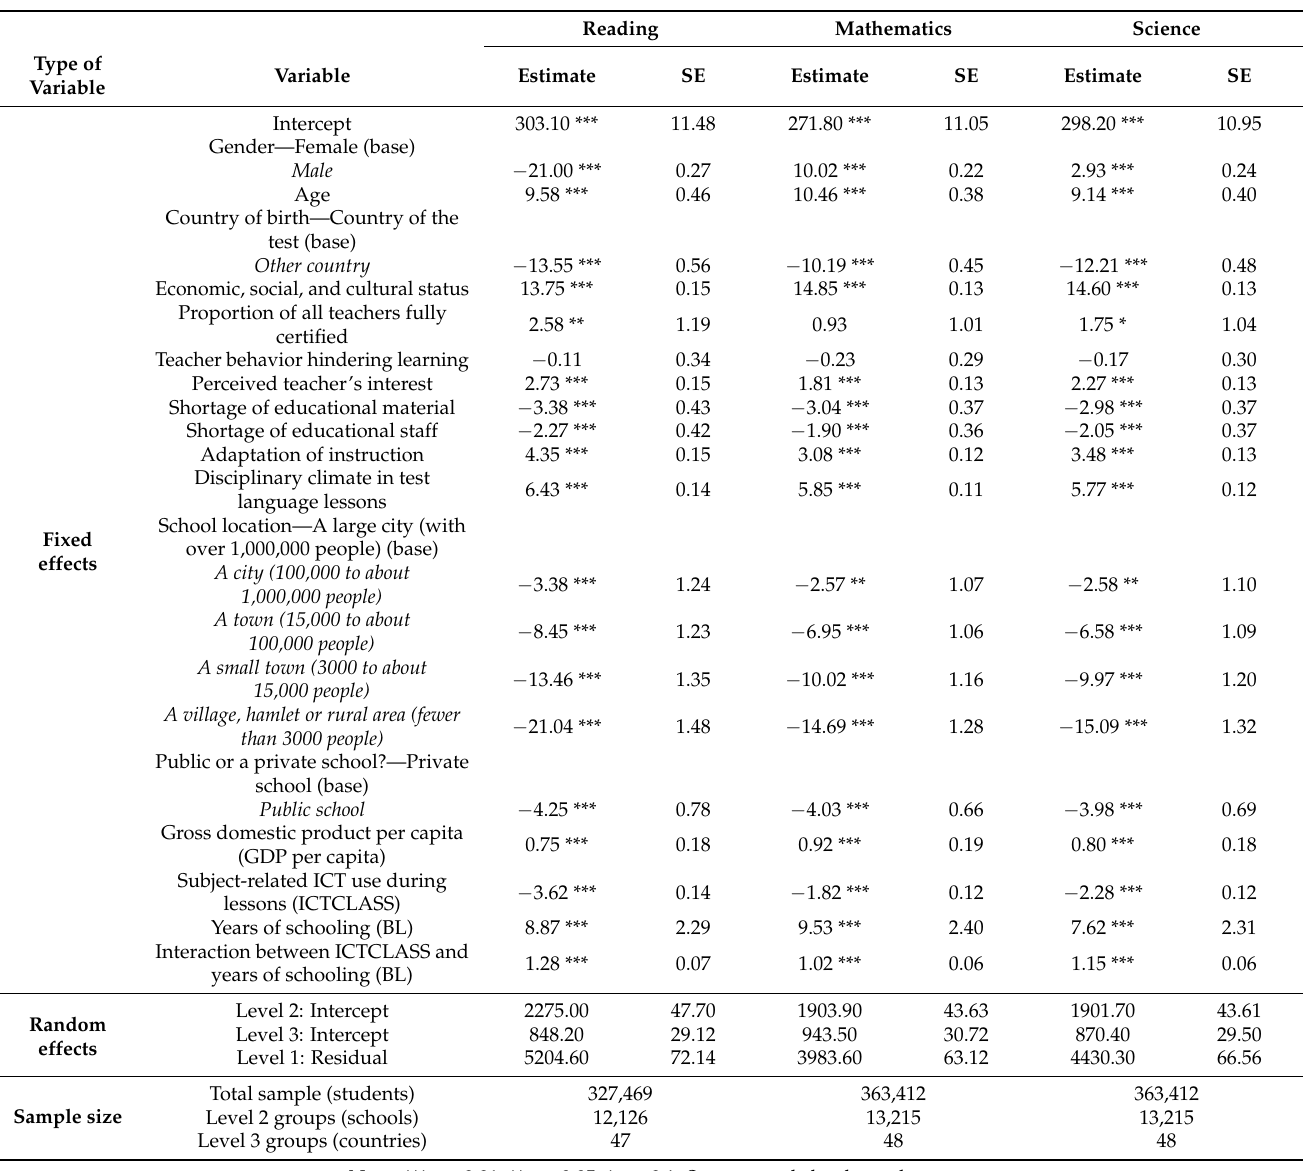
Table 3. HLM estimations predicting students’ outcomes and considering years of schooling (BL) as an indicator of the countries’ stock of human